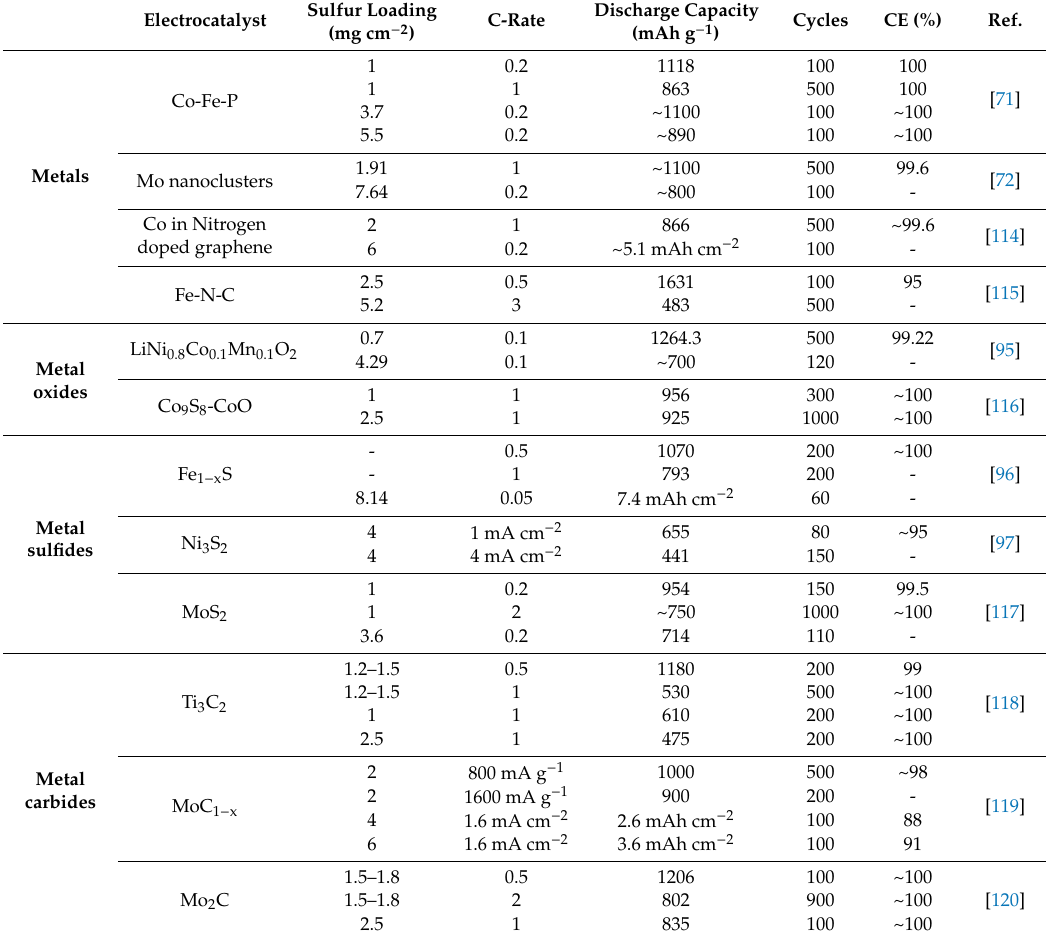
Table 3. Comparison of sulfur loadings, current rates, and the corresponding capacity, cycle life, coulombic e ffi ciency delivered by the Li-S batteries when various electrocatalytic sulfur hosts are